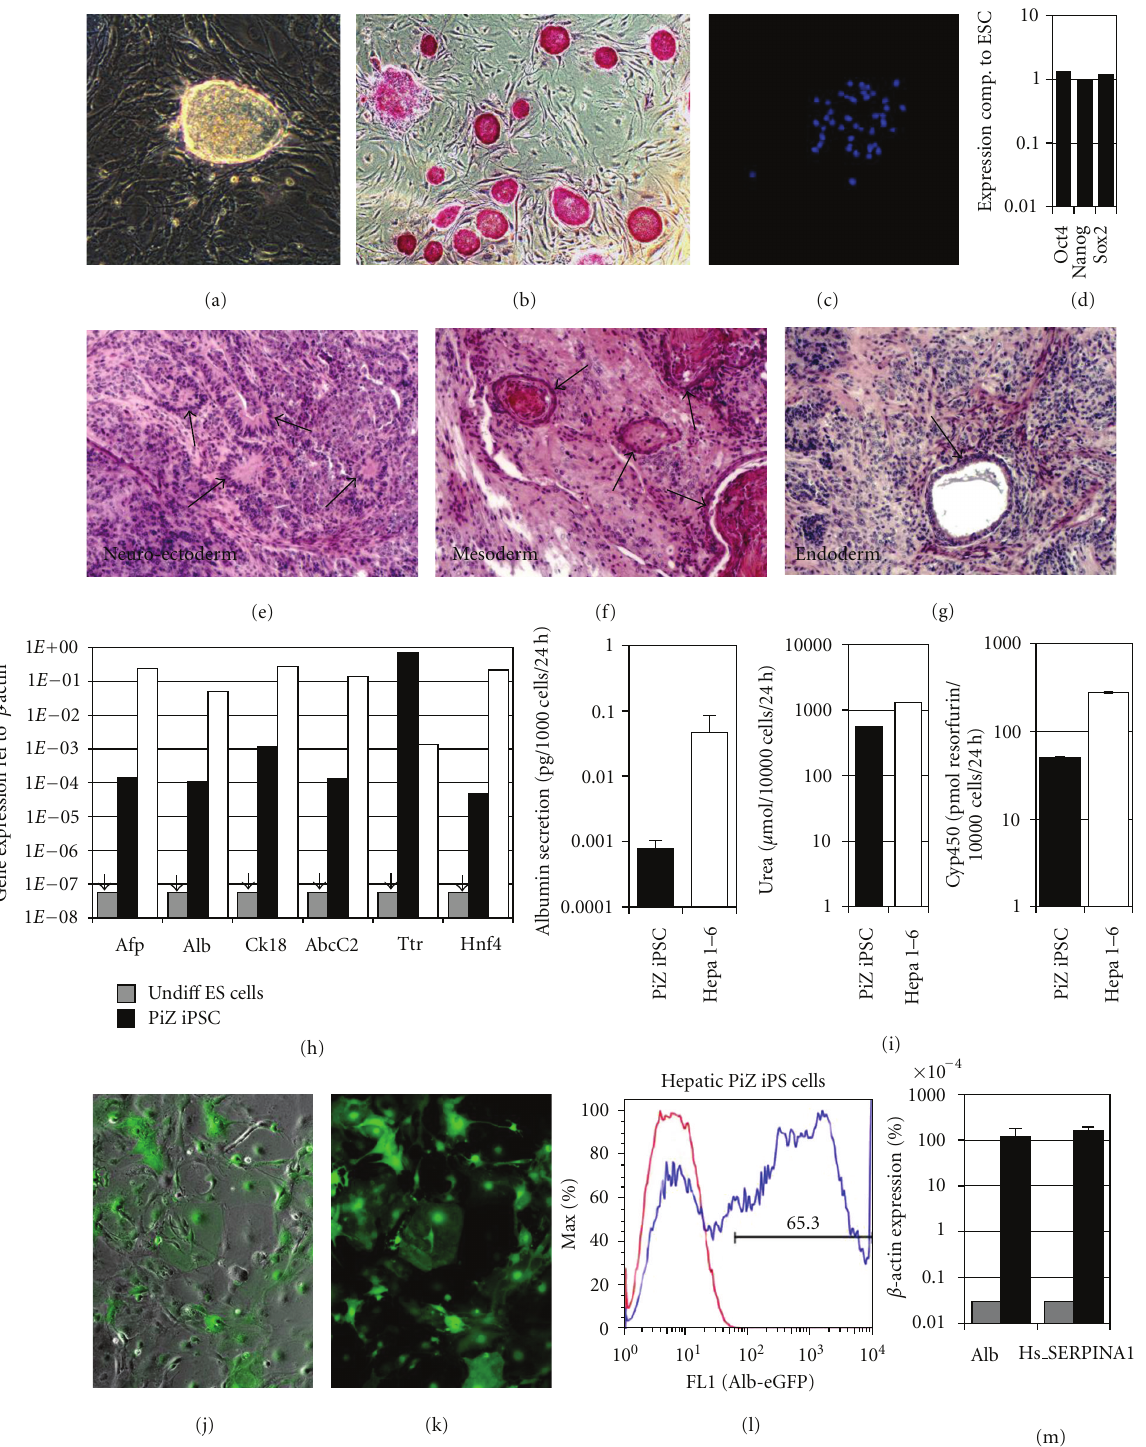
Figure 5: PiZ iPS cells. (a) iPSCs generated from ear fibroblasts isolated from PiZ mice using lentiviral vectors expressing human OCT4, KLF4, and SOX2. (b) Staining for alkaline phosphatase expression of PiZ-iPSCs. (c) Karyotype analysis of DAPI stained metaphase spreads. (d) qRT PCR analysis for endogenous expression of pluripotency markers Oct4, Nanog and Sox2 in PiZ-iPS and OG2 ES. (e)–(g) PiZ iPS were able to form tissues from all three germ layers when transplanted subcutaneously into NOD/SCID mice. (h) qRT PCR analysis for hepatic marker genes Afp, Alb, Ck18, Abcc2, Ttr, and Hnf4 α . Undi ff erentiated cells served as negative control, in which no hepatic gene expression was determined until cycle 45 ( ↓ ). (i) Functional analysis of iPSC-derived hepatic cells: albumin secretion detected by ELISA, urea production, and CYP450 activity assay. (j)-(k) Day 5 + 9 + 14 hepatic di ff erentiated PiZ-iPSCs transduced on day 5 + 9 + 3 with a lentiviral Alb-eGFP reporter construct (l) FACS-analysis on day 5 + 9 + 14 of hepatic di ff erentiation for Alb-GFP positive cells. (m) qRT PCR analysis for expression of human SERPINA1 and Albumin on d 5 + 9 + 14 of cytokine-based di ff erentiation, compared to undi ff erentiated PiZ-iPSCs (grey